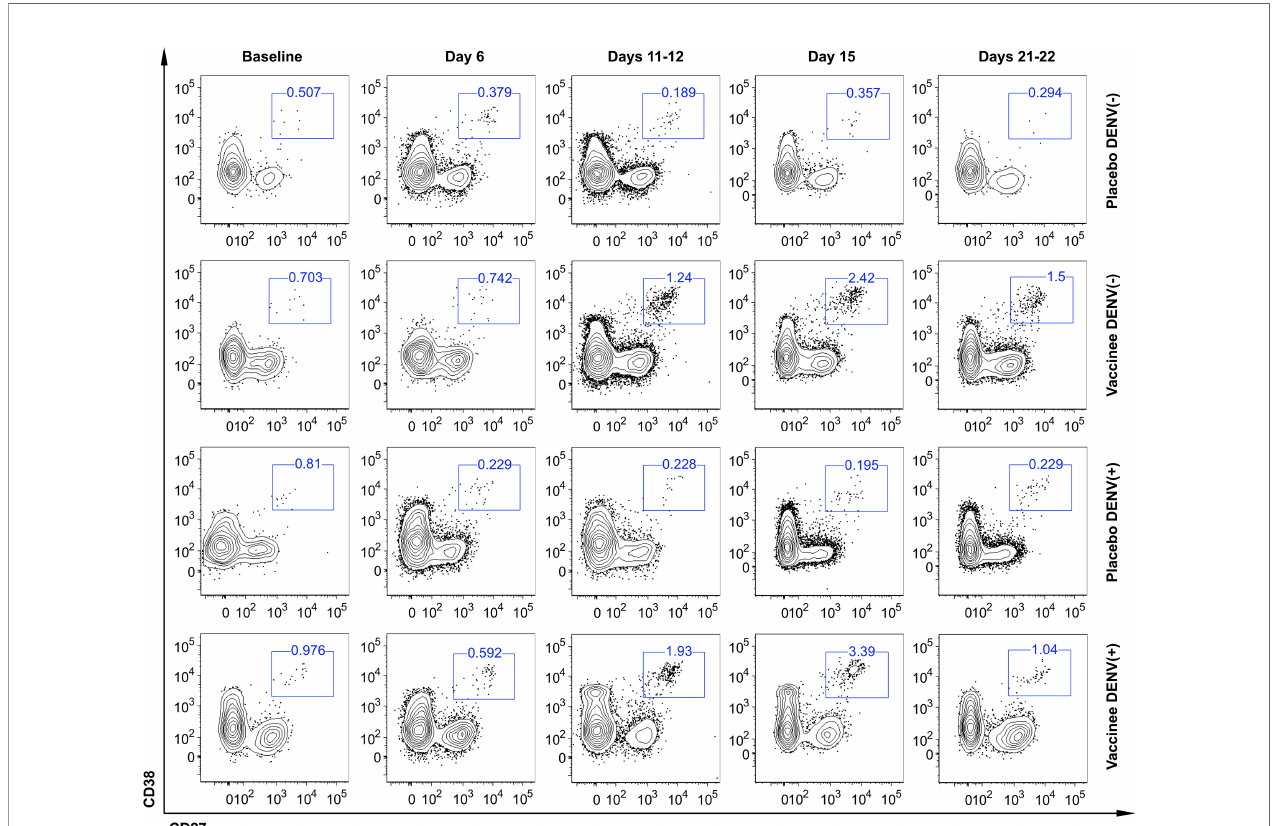
FIGURE 3 | Representative fl ow cytometric analysis of circulating plasmablast in naïve (DENV ( – )) and DENV-pre-exposed (DENV(+)) volunteers enrolled in the Phase II clinical trial evaluated before (baseline) and after vaccination (days 6, 11-12, 15, 21-22). All plots represent the frequency of CD27 + CD38 + cells gated on live CD3 - CD14 - CD19 +